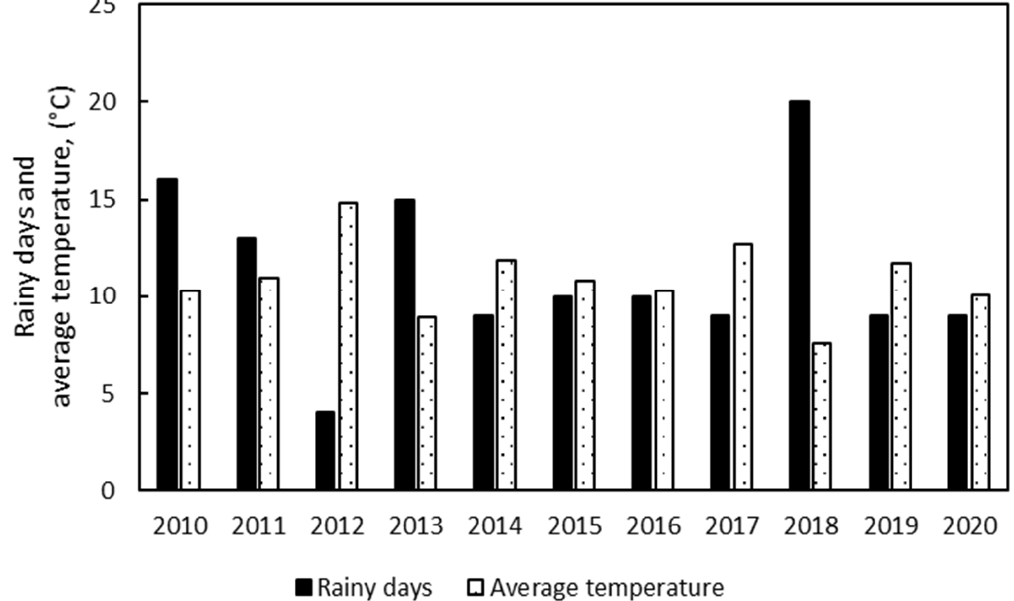
Figure 11. Rainy days and average temperature measured in Milan by the ARPA Lombardia meteorological network in March.